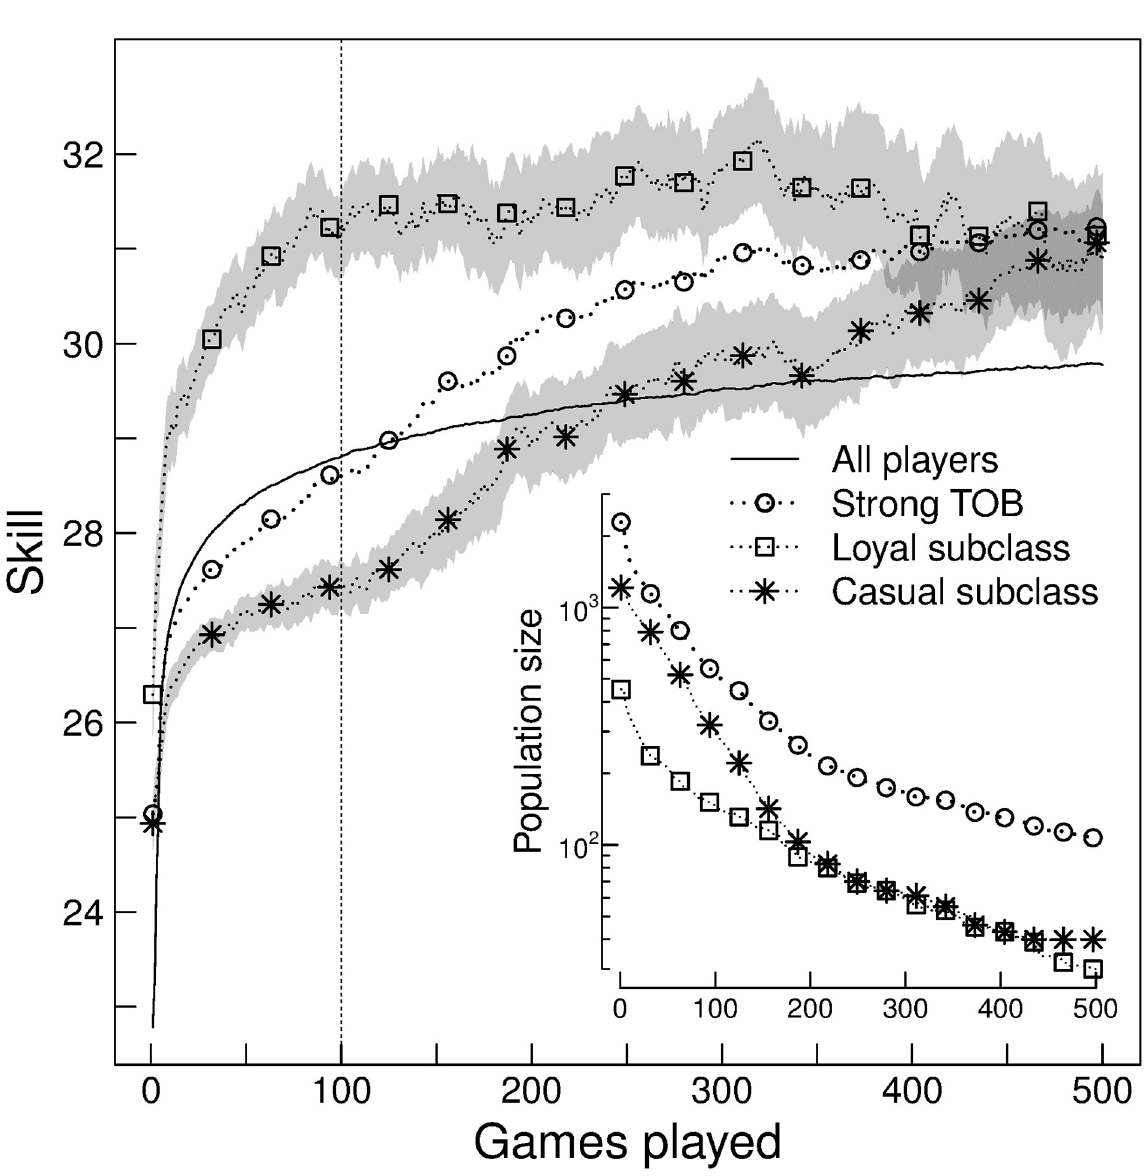
Fig 3. Loyalty influence over strong TOB learning curve. Learning curves of the loyal and casual subclasses of strong TOB. The band represents 95% Wilcoxon rank-sum confident interval, and the middle line represents the pseudomedian. As a reference, we show the learning curve of the whole population and the strong TOB. Results are analogous to those obtained with mean and 95% t-test confident interval. The vertical line at 100 of games played indicates the analysis performed in Fig 4.